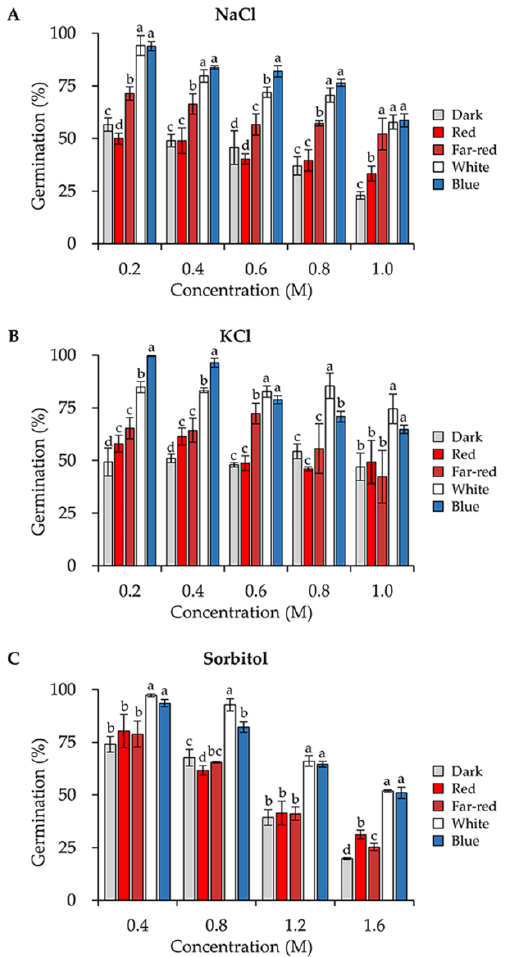
Figure 4. Osmotic stress tolerance of conidia formed under different wavelengths of light. Conidia were spread on the PDA medium with increasing concentrations of NaCl ( A ), KCl ( B ) or sorbitol ( C ) as indicated, and the germination rates were calculated after 30 h of incubation in the dark. Error bars indicate SD of three biological replicates. One-way ANOVA was used for the statistical analysis ( p ≤ 0.05). Means significantly different from each other do not share the same letter.